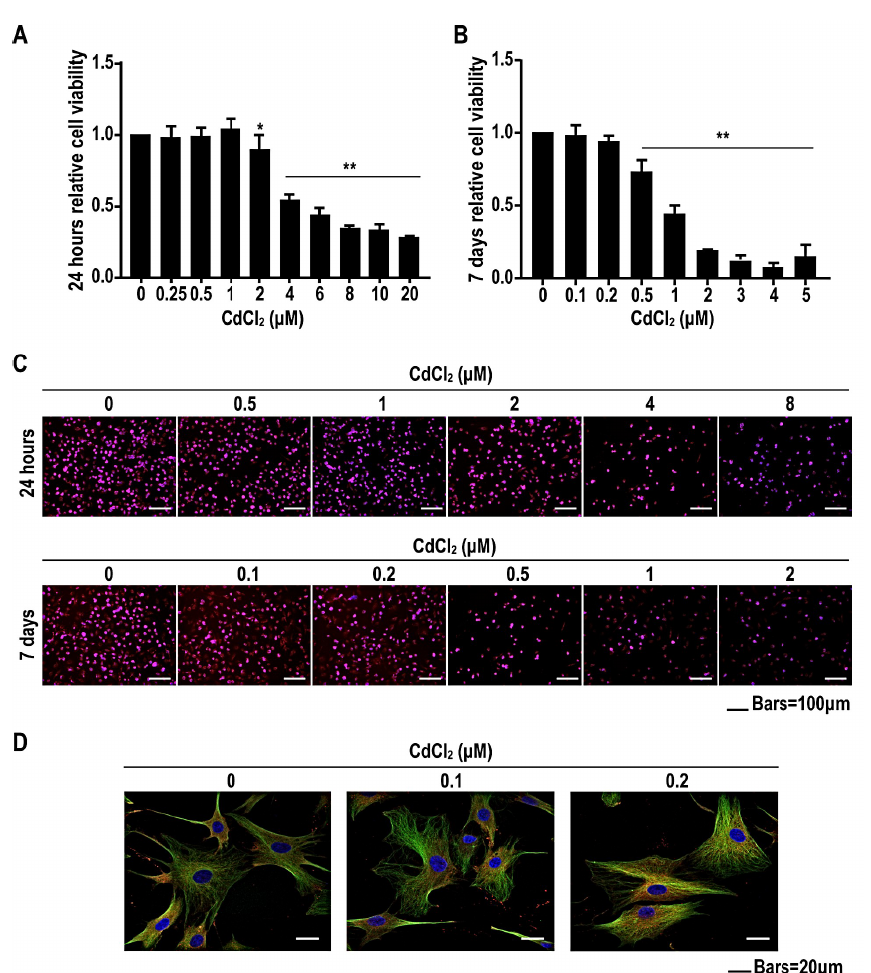
Figure 2. Low concentrations of cadmium have no effect on cell viability, and high concentrations of cadmium reduce cell viability of BMMSCs. BMMSCs were exposed to 0, 0.25, 0.5, 1.0, 2.0, 4.0, 6.0, 8.0, 10, or 20 µ M CdCl 2 for 24 h. ( A ) The viability of BMMSCs was detected by 3-(4,5-dimethylthiazol-2-yl) -2,5-diphenyltetrazolium bromide (MTT) analysis (mean ± SD, n = 5). * p < 0.05, ** p < 0.01, different from control BMMSCs. BMMSCs were treated with 0, 0.1, 0.2, 0.5, 1.0, 2.0, 3.0, 4.0, or 5.0 µ M CdCl 2 for 7 days. ( B ) The viability of BMMSCs was detected by MTT analysis. (mean ± SD, n = 5). ** p < 0.01, different from control BMMSCs. BMMSCs were exposed to 0, 0.5, 1, 2, 4, and 8 µ M CdCl 2 for 24 h, or 0, 0.1, 0.2, 0.5, 1, and 2 µ M CdCl 2 for 7 days. ( C ) The proliferation rate of BMMSCs was detected by 5-ethynyl-2 (cid:48) -deoxyuridine (EdU). Scale bar, 100 µ Mm. BMMSCs were exposed to 0, 0.1, or 0.2 µ M CdCl 2 for 24 h. ( D ) Cytoskeleton of BMMSCs were shown by immunofluorescence and confocal microscopic analyses Nuclei were stained blue with 4 (cid:48) ,6-diamidino-2-phenylindole (DAPI), and cytoplasm was stained green and red with α -tubulin and F-actin. Scale bar, 20 µ